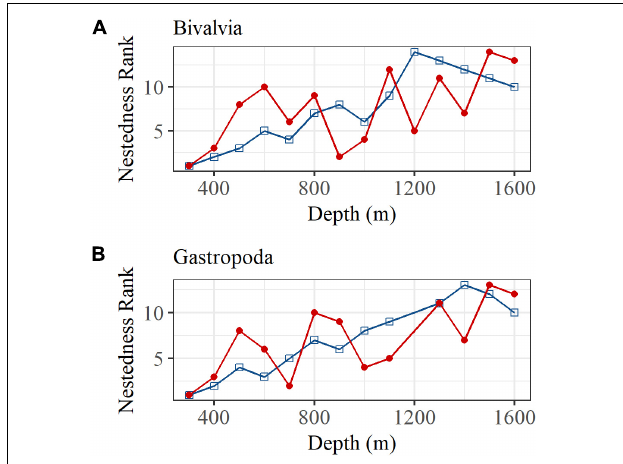
FIGURE 6 | The rank order of nestedness calculated using the BINMATNEST software for (A) bivalves and (B) gastropods, north (blue squares and line) and south (red dots and line) of the GIF ridge.